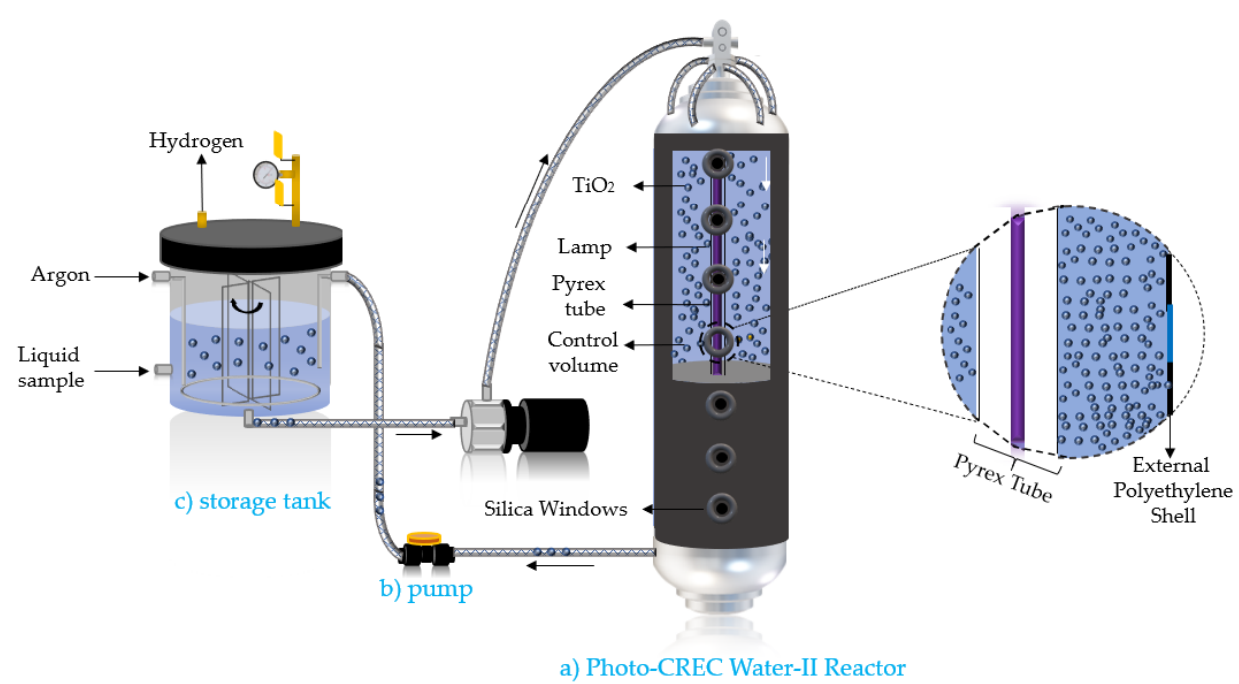
Figure 17. Schematic representation of the Photo-CREC Water-II Reactor: ( a ) tubular Photo-CREC Water-II Reactor with downflow slurry circulation; ( b ) centrifugal pump; and ( c ) sealed hydrogen storage tank.